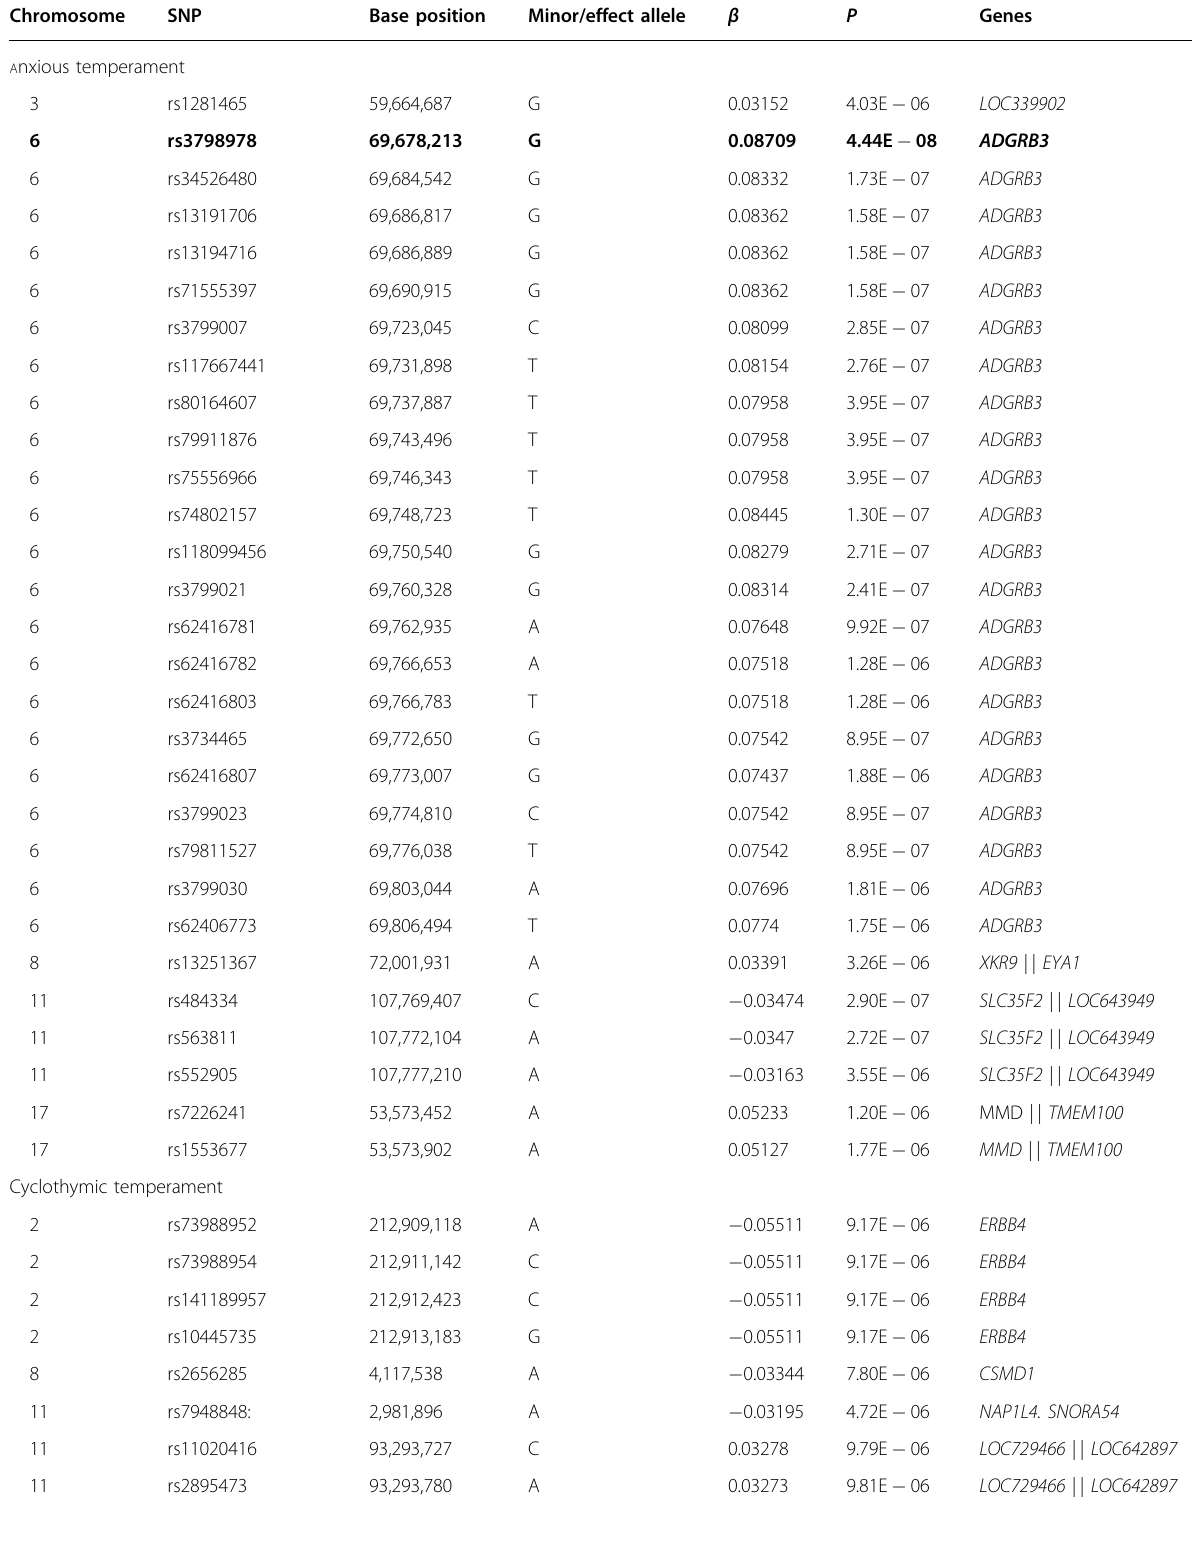
Table 1 Most signi fi cant SNPs with genome-wide or suggestive signi fi cances for the fi ve affective